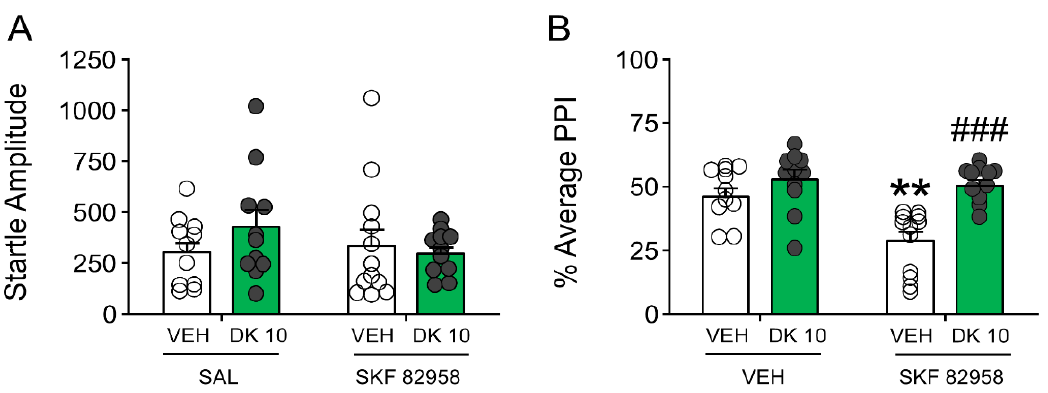
Figure 8. Effects of DK-I-56-1 (DK, 10 mg/kg, IP) on ( A ) startle response and ( B ) prepulse inhibition (PPI) in C57/BL6 mice treated with SKF 82958 (0.5 mg/kg, IP). Two-way ANOVA detected that SKF 82958 dramatically reduced PPI (Main effect: F(1,42) = 9.73, p = 0.003), and DK countered the PPI deficits caused by the D 1 receptor agonist (Interaction: F(1,42) = 5.43, p = 0.02). Significance levels refer to the results of post-hoc comparisons. ** p < 0.01 vs. mice treated with the vehicle of DK (VEH) and saline (SAL, controlling for SKF 82958); ### p = 0.0001 vs. mice treated with VEH and SKF 82958. n = 11–12/group. For further details, see text.